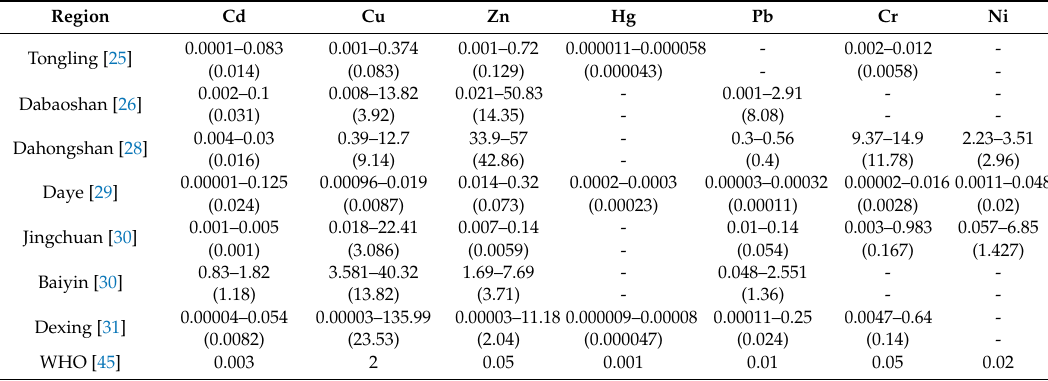
Table 2. Distribution characteristics of heavy metal concentration in water around typical copper mines (mg /